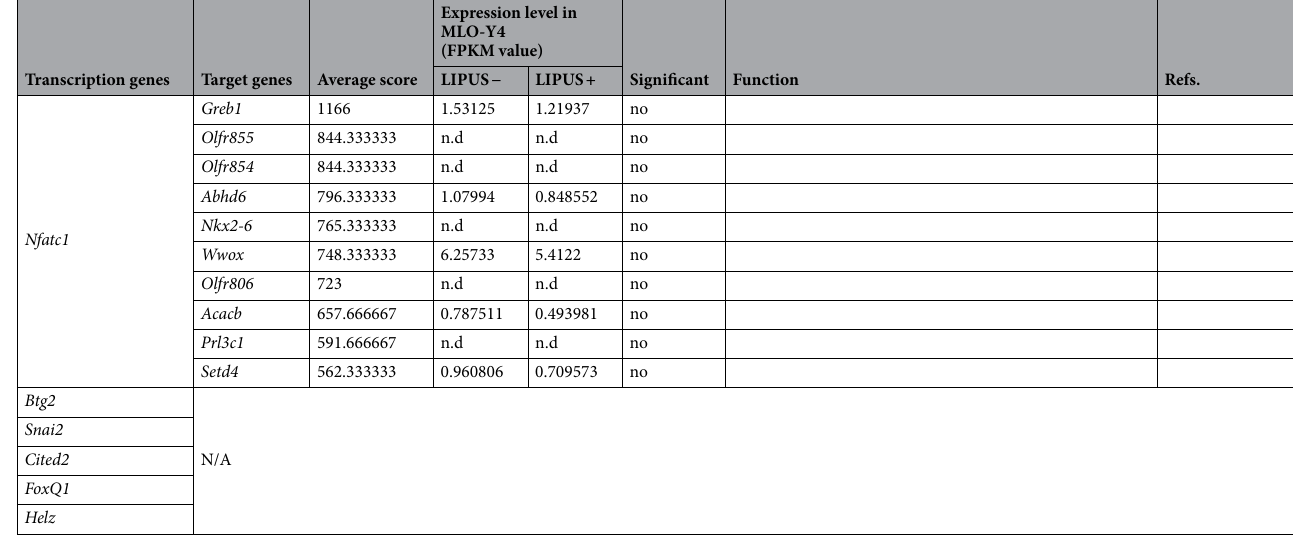
Table 2. List of genes targeted by transcription factor